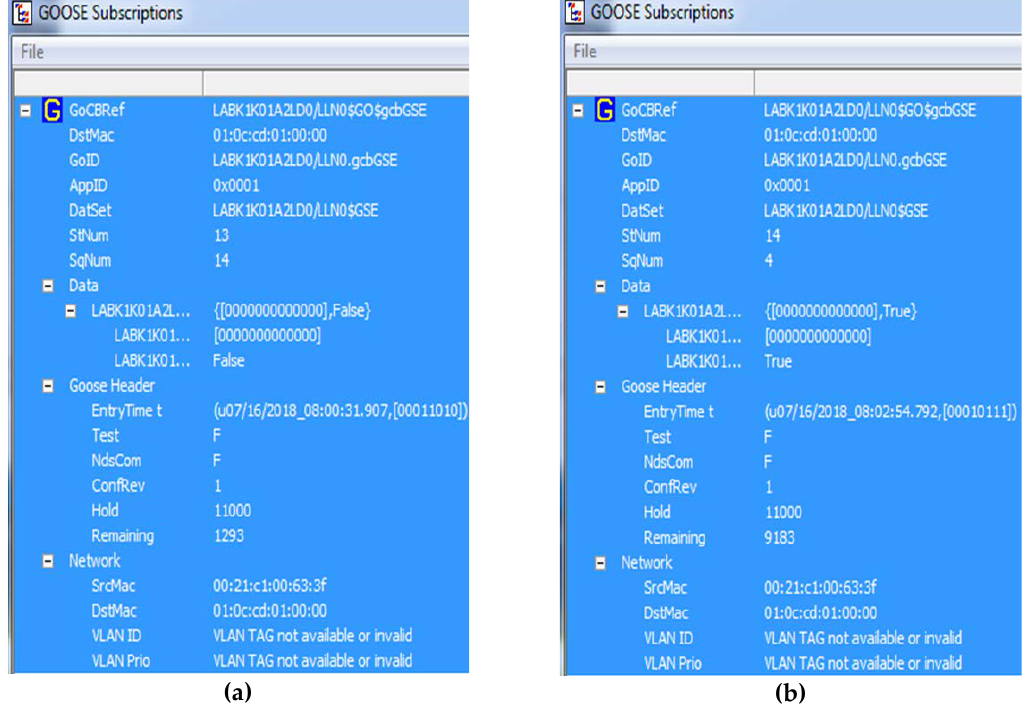
Figure 14. The full scheme of testing the IEC 61850 (SMV-GOOSE). ( a ) Shows the mapping of a GOOSE message with the dataset details. It shows the tripping signal is false before increasing the current and overcurrent function of IED takes action, ( b ) shows changing of the status to true, which means the GOOSE message (tripping signal) is sent to the